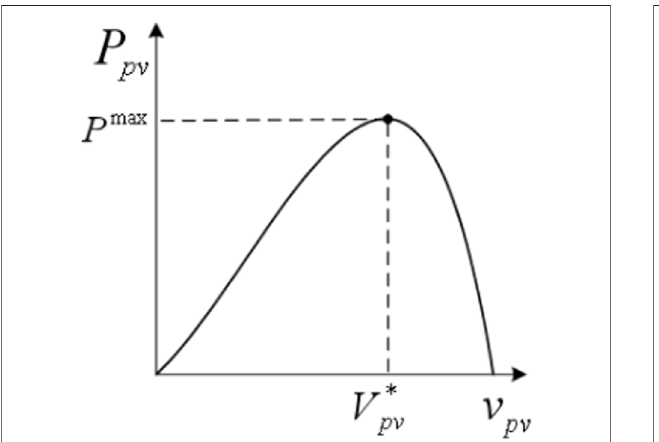
FIGURE 2 | Output model of a PV generator.